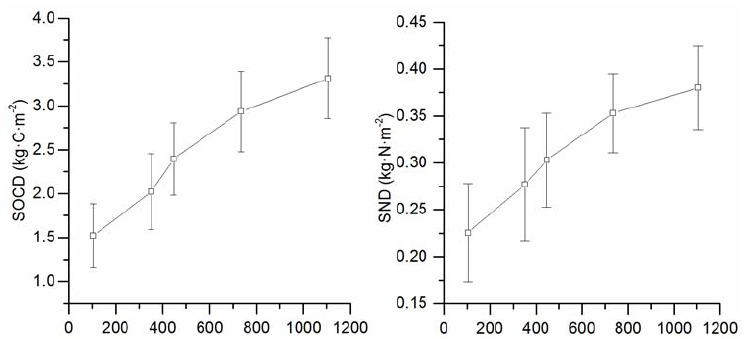
Figure 3. SOCD and SND of cropland with different cultivation duration.